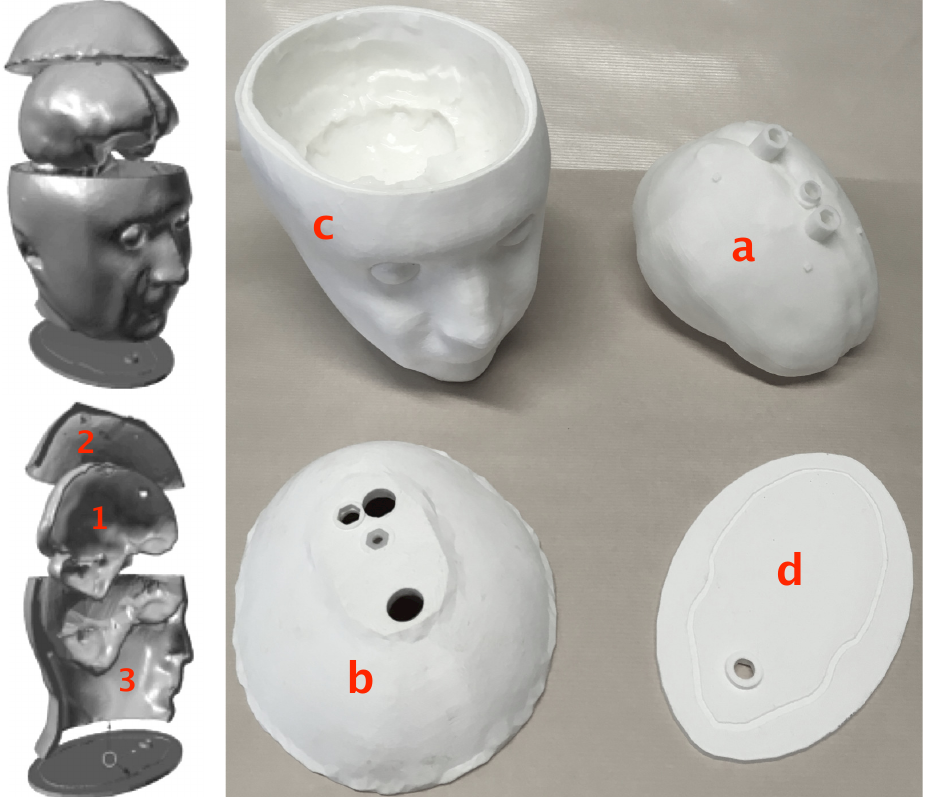
Figure 3. The different parts of the head phantom: (1) The inner tank ( a ) contains the brain TMM, (2) the upper cavity contains the cerebrospinal fluid (CSF) TMM, and (3) the lower one contains an average tissue medium mimicking mixture. The top and bottom of part ( c ) are clipped, respectively, to the part ( b ) and to the plate ( d ) by means of a tenon–mortise system that runs all around the joints, and the different parts are glued once in place, while the brain tank is held in place by several stops. Table 1. Composition and properties of breast TMMs at 2.45 GHz and 37 ◦ C (group: T =